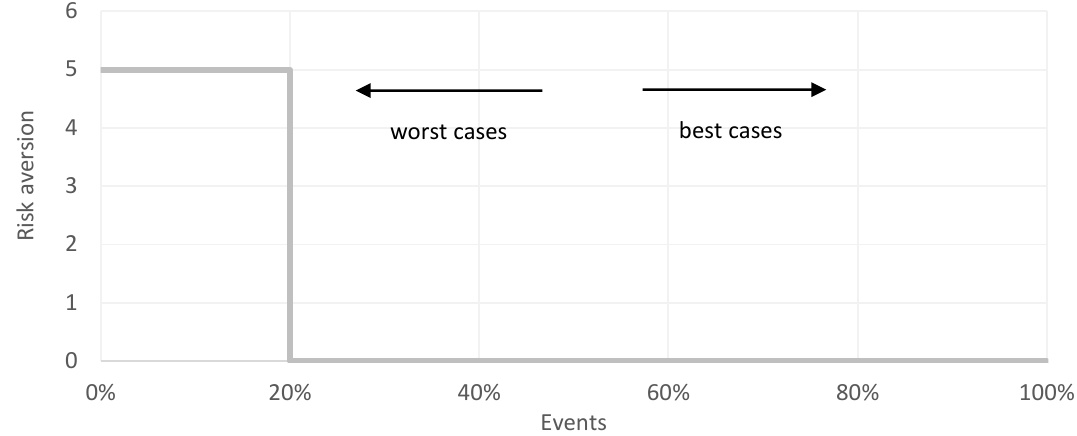
Figure 1. Example of a risk aversion function ( ) x ϕ for